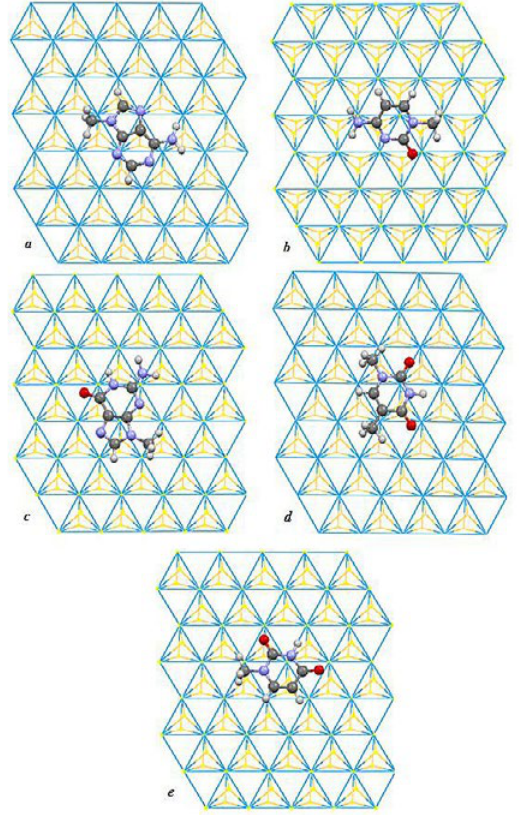
Fig. 2. Optimized structures of nucleobases adsorbed onto monolayer WS .[( a ) Adenine, ( b ) Cytosine, ( c ) Guanine, ( d ) 2 Thymine and ( e ) Uracil]. (Purple: Mo, Yellow: S, Red: O, Blue: N, Gray: C and White: